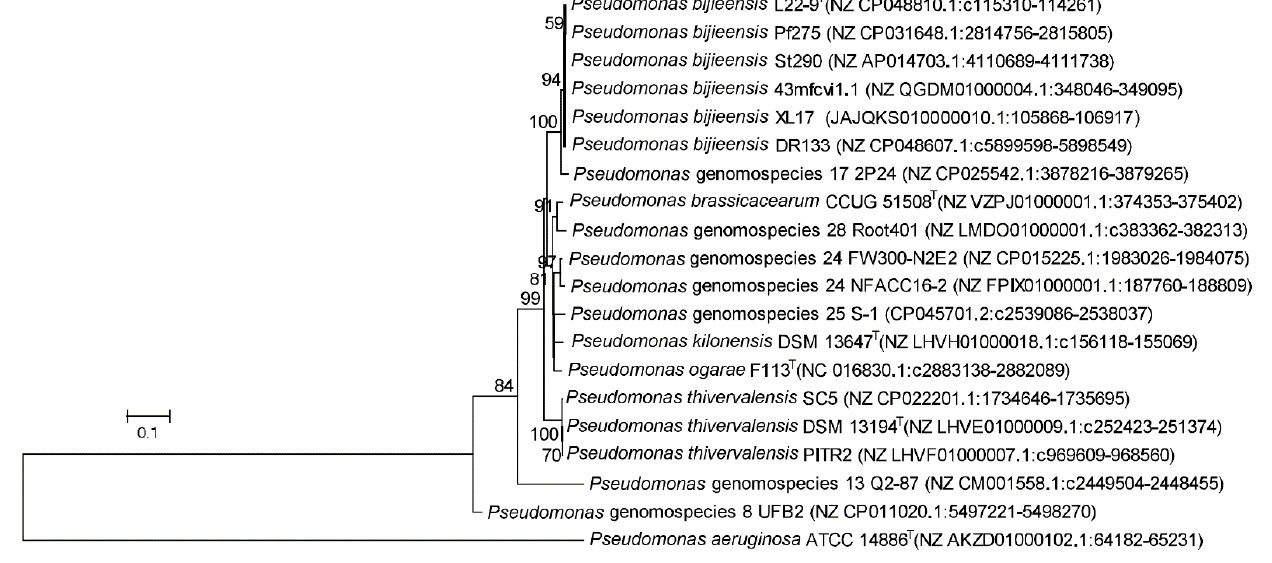
Figure 7. Maximum likelihood phylogenetic tree based on complete phlD gene sequences (1050 po- sitions) encoding type III polyketide synthase of strains within the Pseudomonas corrugata subgroup. P. aeruginosa ATCC 14886 T was used as outgroup. The percentages of replicate trees (>50%) in which the associated taxa clustered together in the bootstrap test (1000 replicates) are shown at the nodes. The scale bar indicates 0.1 substitutions per site. The phlD gene sequences were extracted from whole genome sequences whose accession numbers in GenBank are indicated in